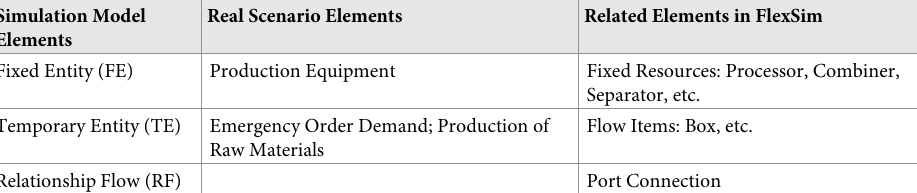
Table 1. Real scenario elements and simulation model elements corresponding to